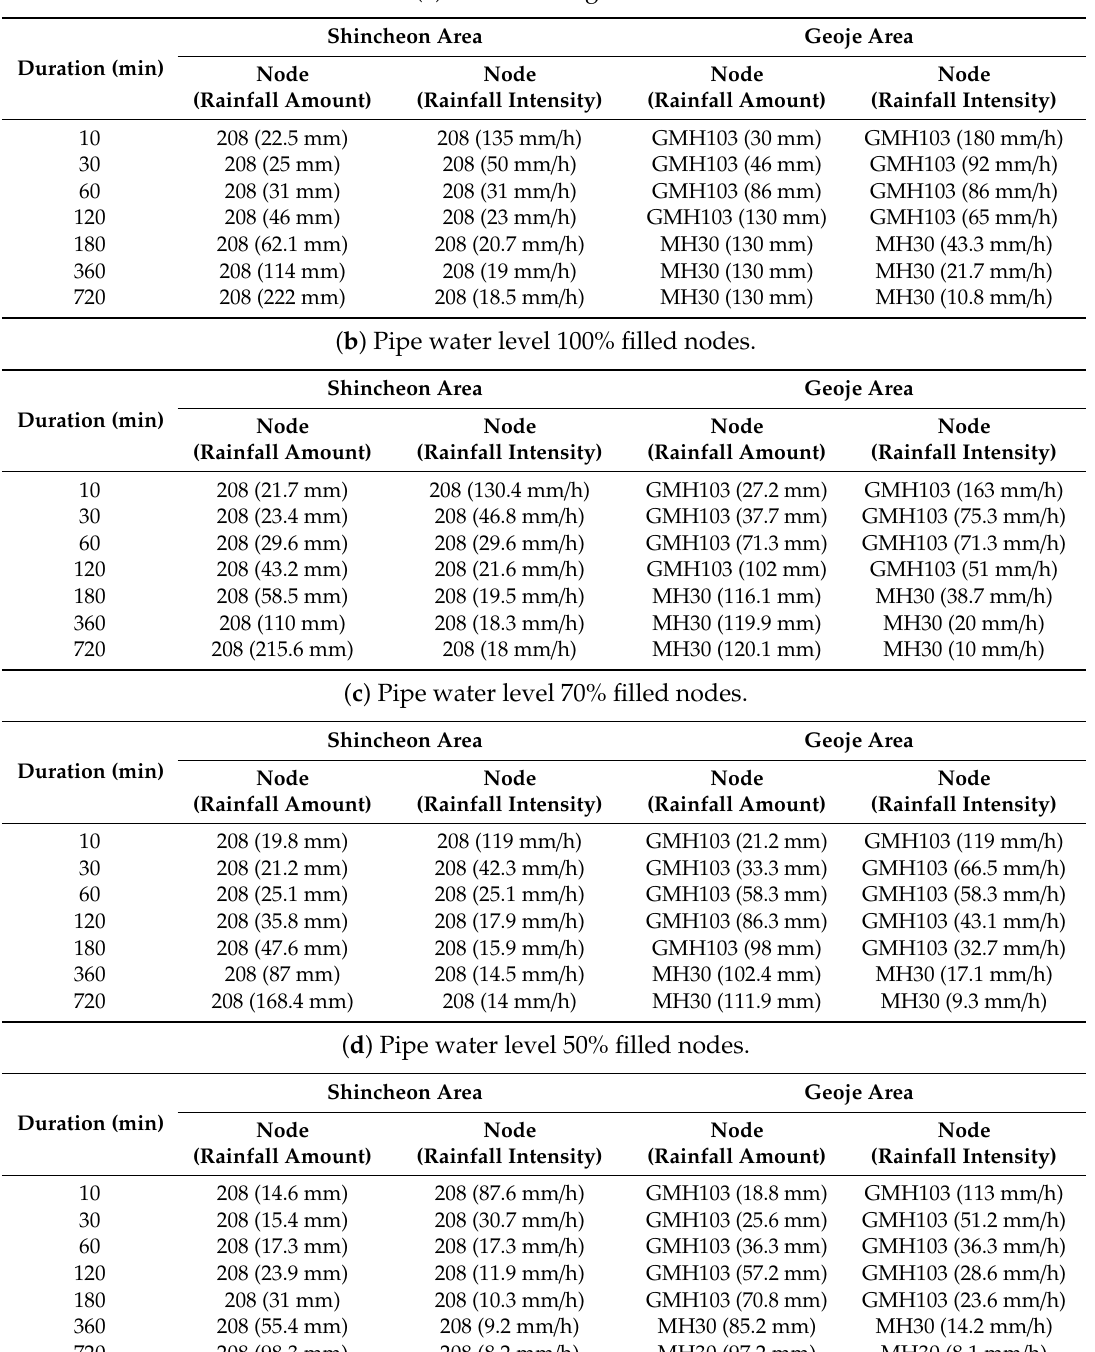
Table 2. Summary of four criteria